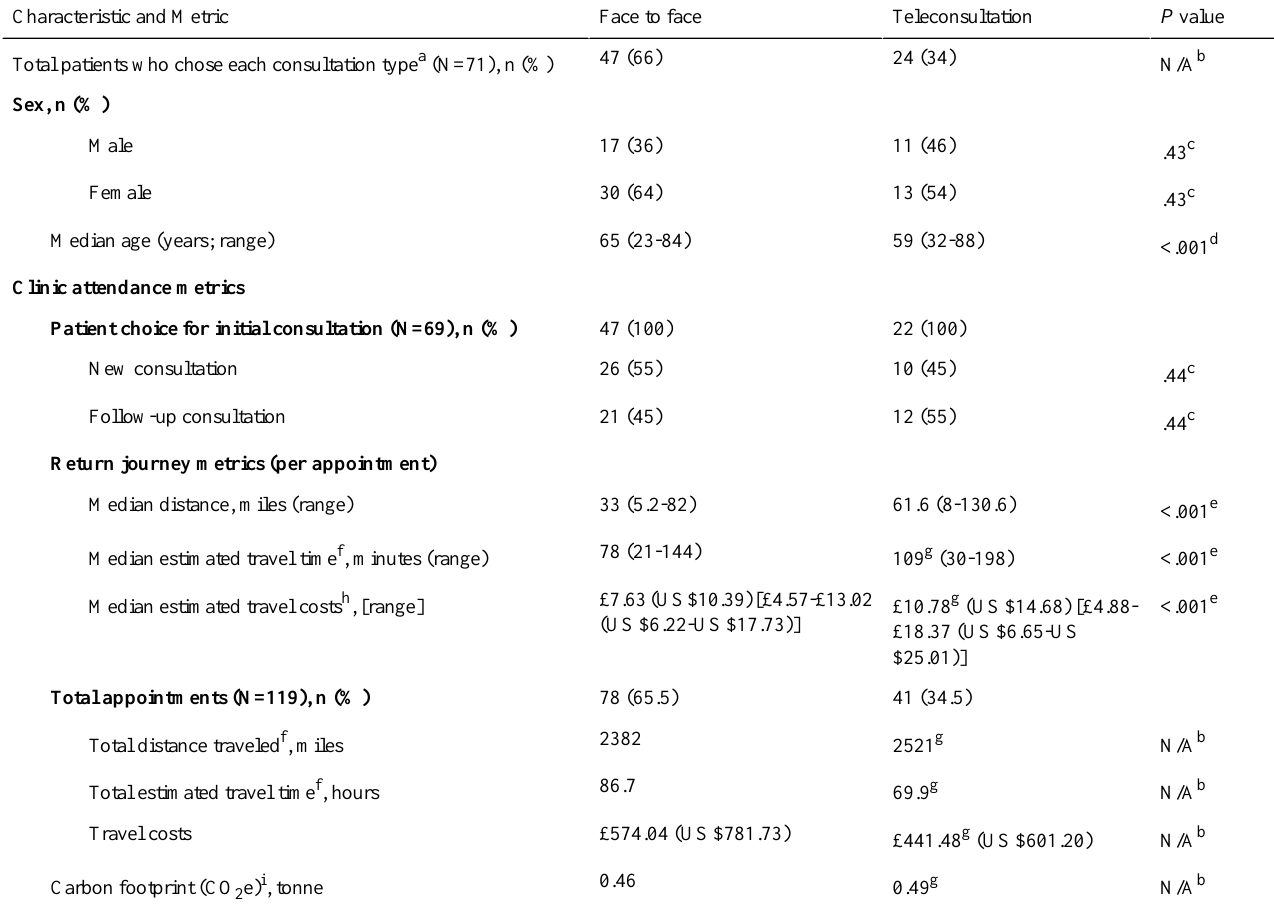
Table 1. Classification of the study participants (N=69) based on their appointment choice and clinic attendance metrics.